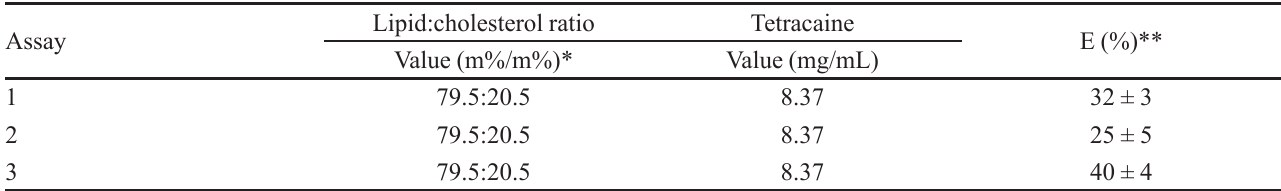
TABLE III - Results of experiments performed in triplicate using 79.5:20.5 lipid: cholesterol ratio (%, w/w) and tetracaine concentration of 8.37 mg / mL for liposomes prepared in hydrophilic phase Lipid:cholesterol Assay